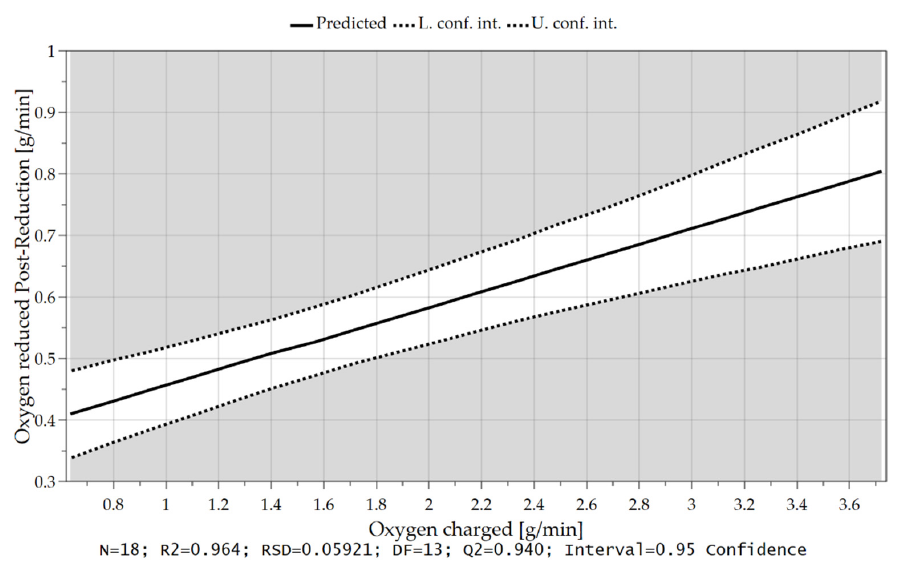
Figure 23. Oxygen removal rate in the post ‐ reduction as a function of hydrogen content during post ‐ reduction.